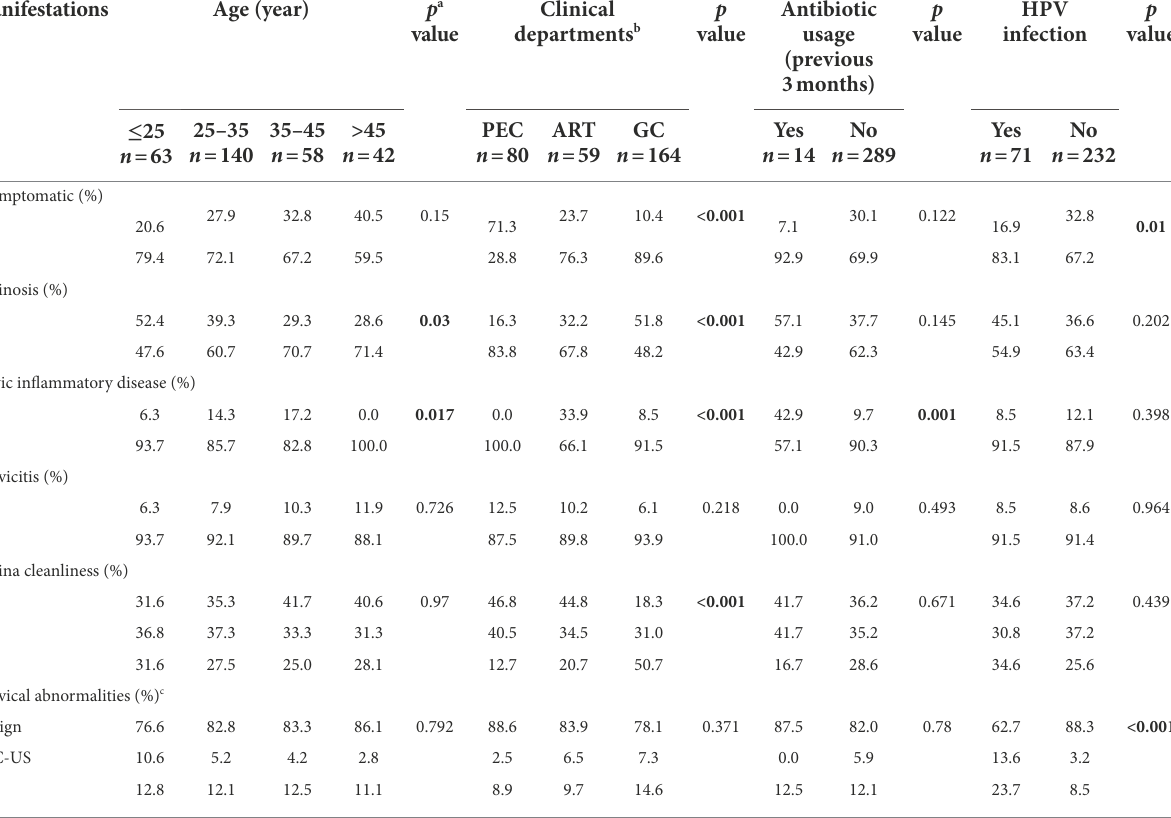
TABLE 3 Clinical manifestations of C. trachomatis -infected women with respect to age, clinical departments, antibiotic usage and HPV infection.